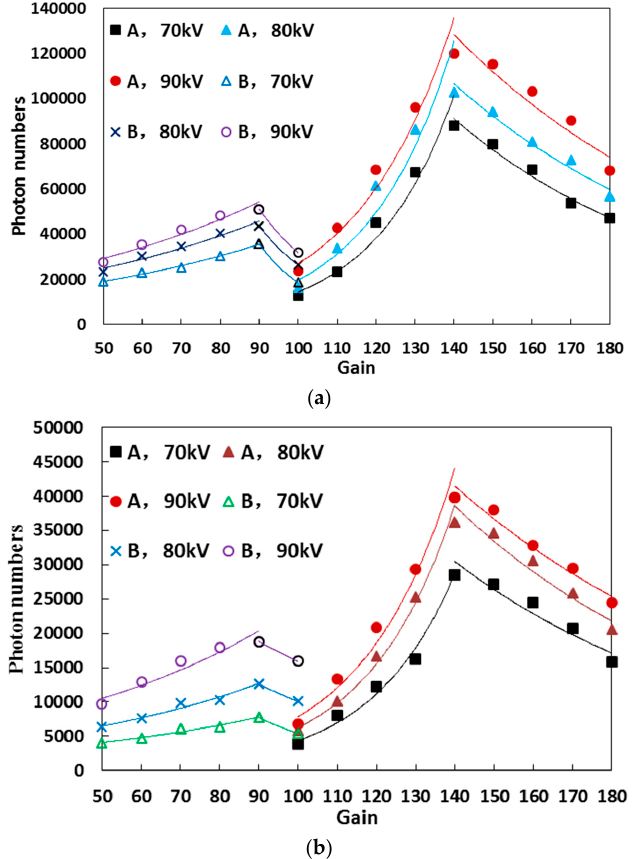
Figure 8. Influence of imager gains on corona discharge photon numbers for sample I ( p = 98.09 kPa; T = 20 °C; RH = 78.2%). ( a ) d = 6 m; ( b ) d = 12 m.